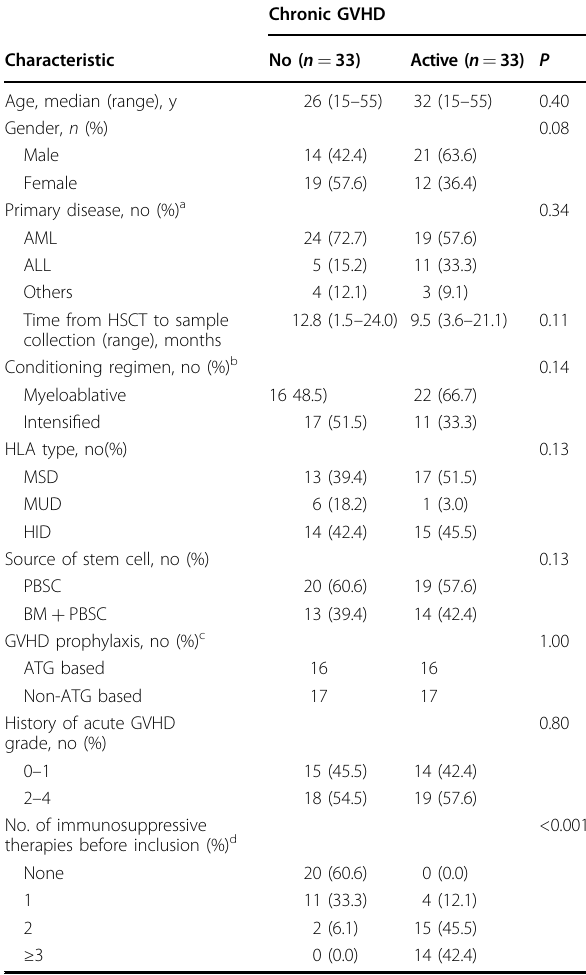
Table 1 Patient